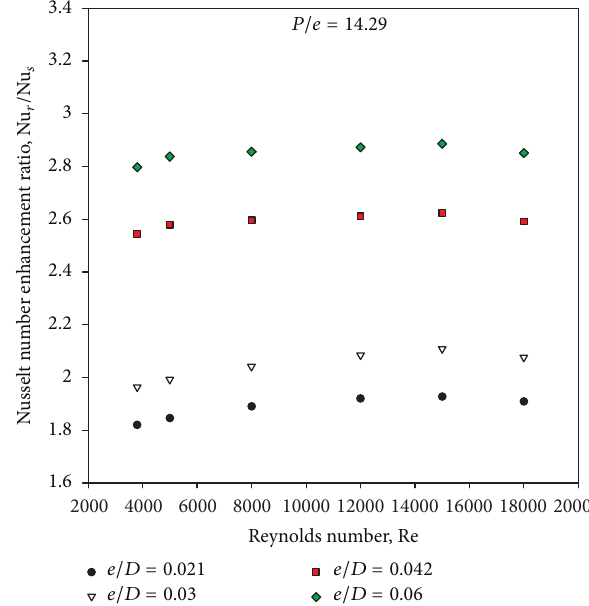
Figure 4: Variation of average Nusselt number with Reynolds num- ber.